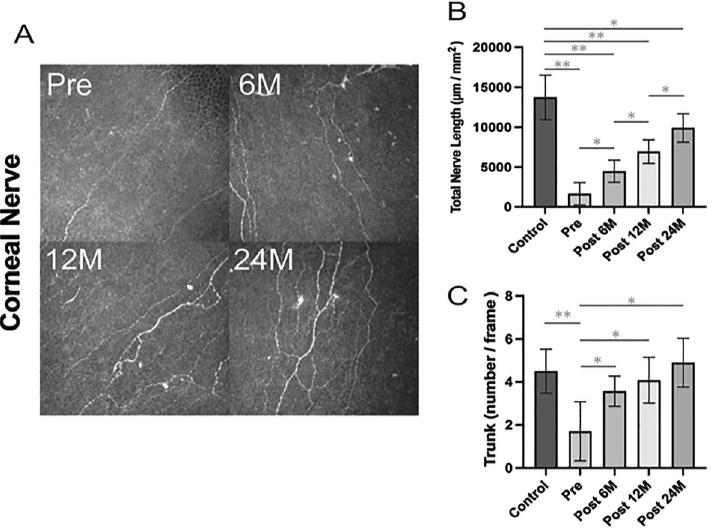
Figure 1. Corneal nerve length and number of nerve trunks. Total nerve length and number of nerve trunks evaluated with IVCM. Left: Representative images at evaluation points. Corneal nerve density gradually increases, and number of nerve trunks also increases after DMEK. Right up: Total nerve length in the control group is significantly more than that at other time points. Total nerve length in pre-DMEK corneas significantly elongates after DMEK for BK in a time-dependent manner. Right down: Number of nerve trunks is significantly higher post-DMEK compared with that pre-DMEK (p < 0.05). DMEK Descemet membrane endothelial keratoplasty, IVCM in vivo confocal microscopy, Pre pre-operative, Post postoperative, M months after surgery. *p < 0.05, **p < 0.001.